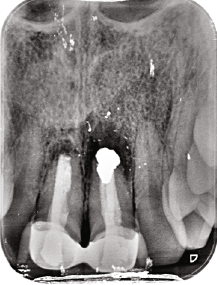
Figure 2: Preoperative periapical radiograph showing a radiolucent image around the root of 1.1 and a larger radiolucency around 2.1.